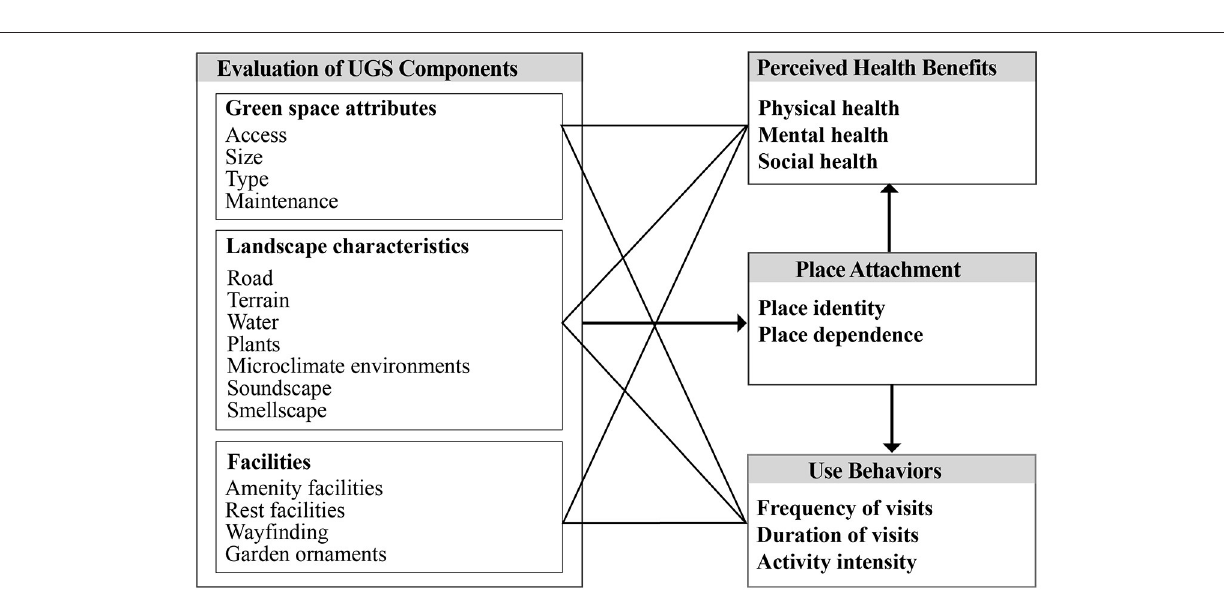
FIGURE 2 | Theoretical framework of the